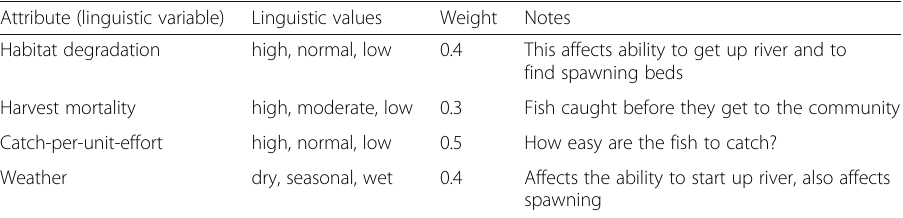
Table 1 Attributes for determining harvest health Attribute (linguistic variable)